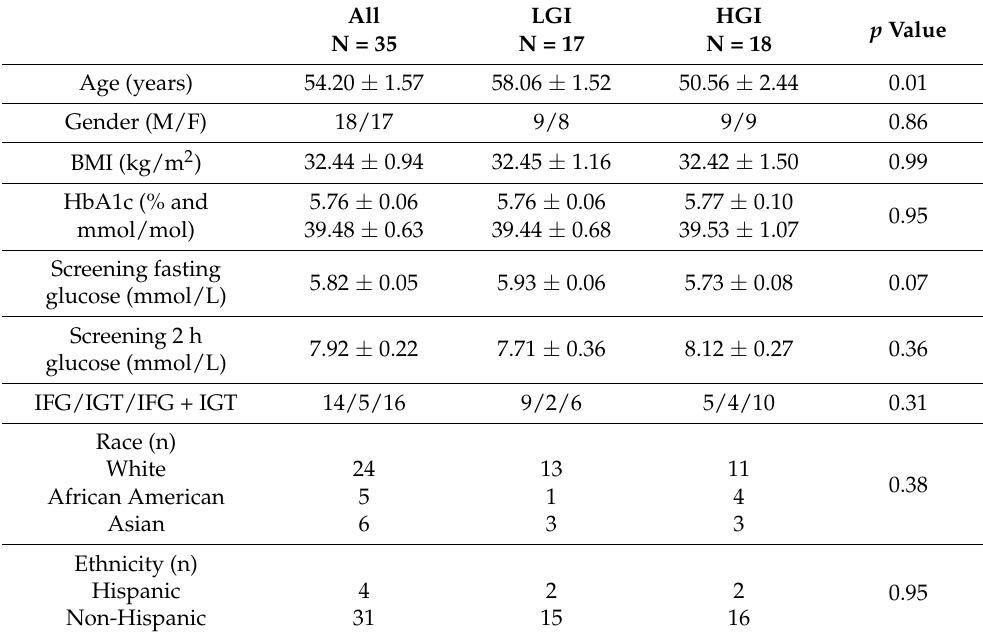
Table 1. Participant Baseline